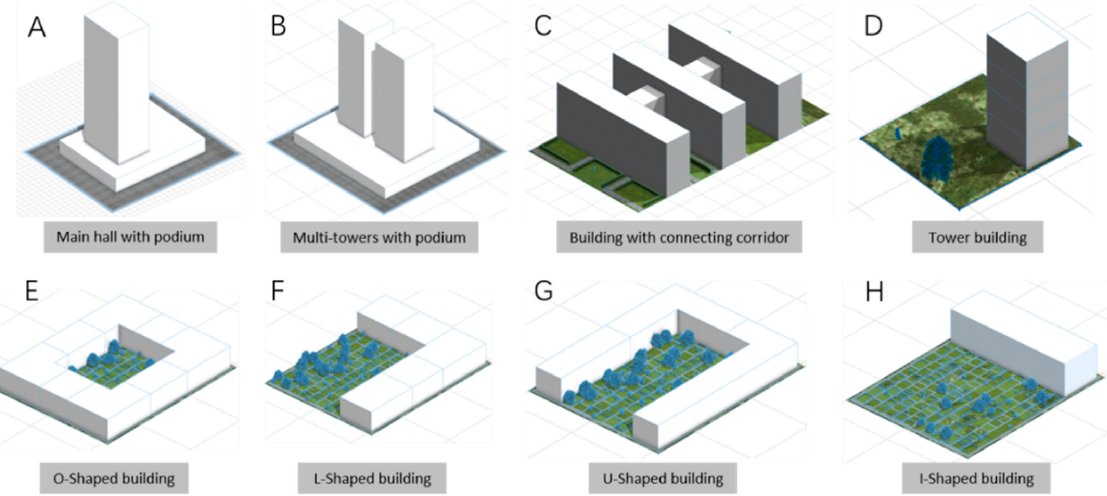
Figure 4. Building library containing 8 common building types (( A ). Main hall with podium, ( B ). Multi-towers with podium, ( C ). Building with connecting corridor, ( D ). Tower building, ( E ). O-shape building, ( F ). L-shape building, ( G ). U-shape building, and ( H ). I-shape building).